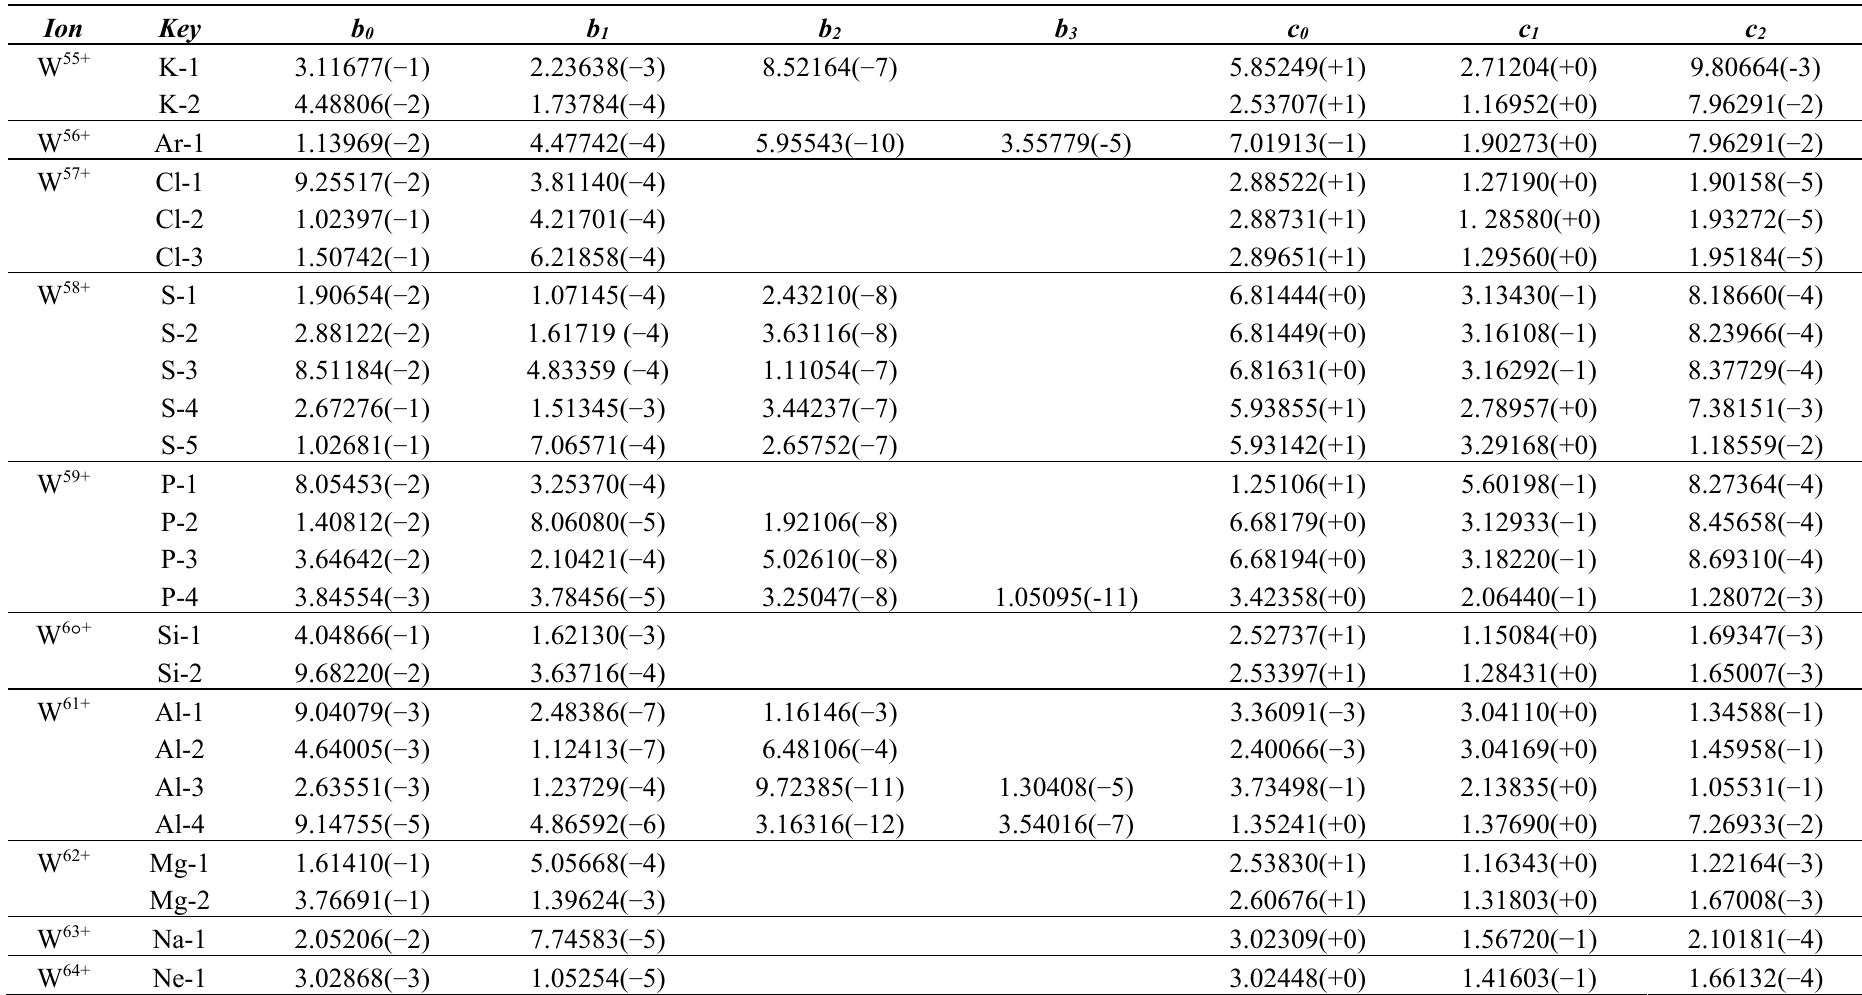
Table 7. Coefficients for the fitting function given in Equation (6) for electron impact excitation cross-sections for all the transitions in K-like W 55+ through Ne-like W 64+ ions. The number in the bracket represents the power of 10 by which the quantity has been